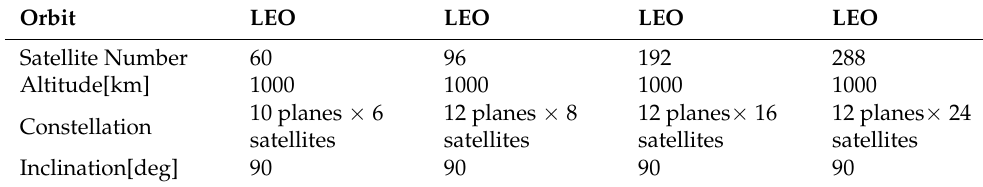
Table 1. Detailed orbital configurations of low earth orbit (LEO) constellations.